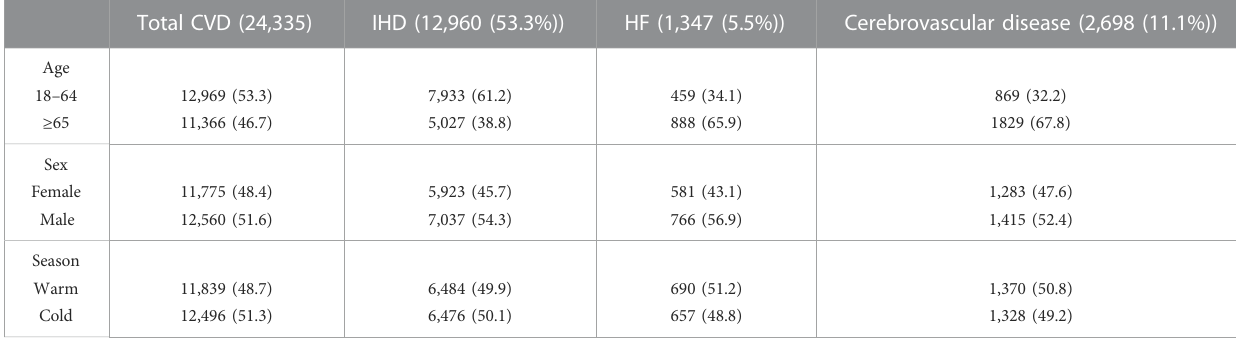
CVD, Cardiovascular disease; IHD, ischemic heart disease; HF, heart failure.